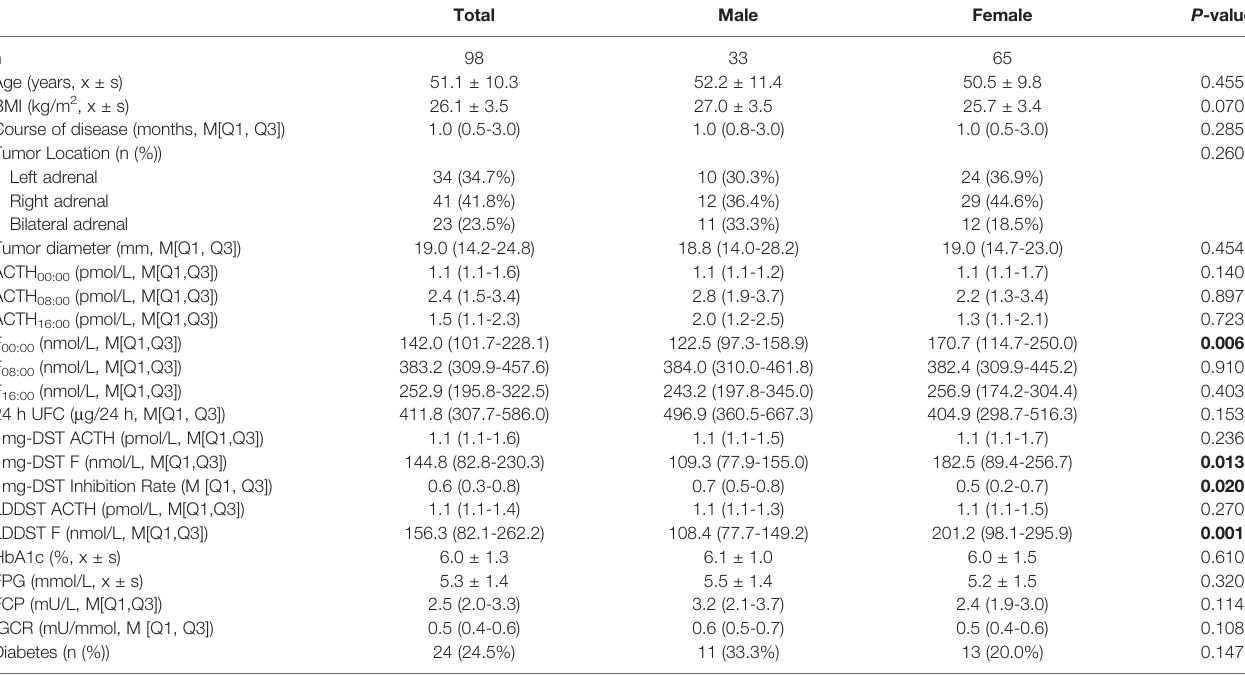
TABLE 1 | Clinical characteristics and biochemical indices of MACS patients in relation to sex